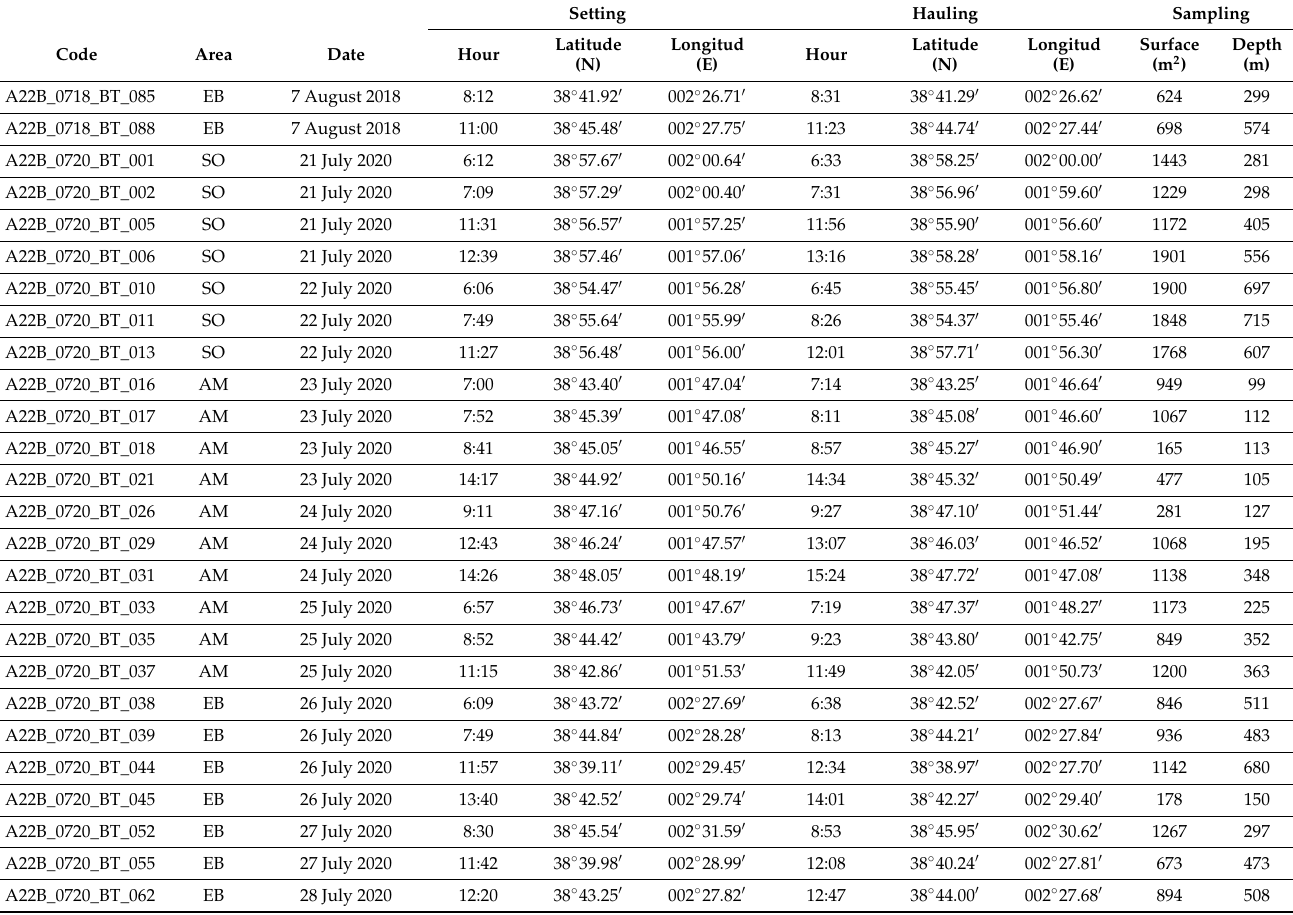
Table A3. Cont. Setting Hauling Sampling